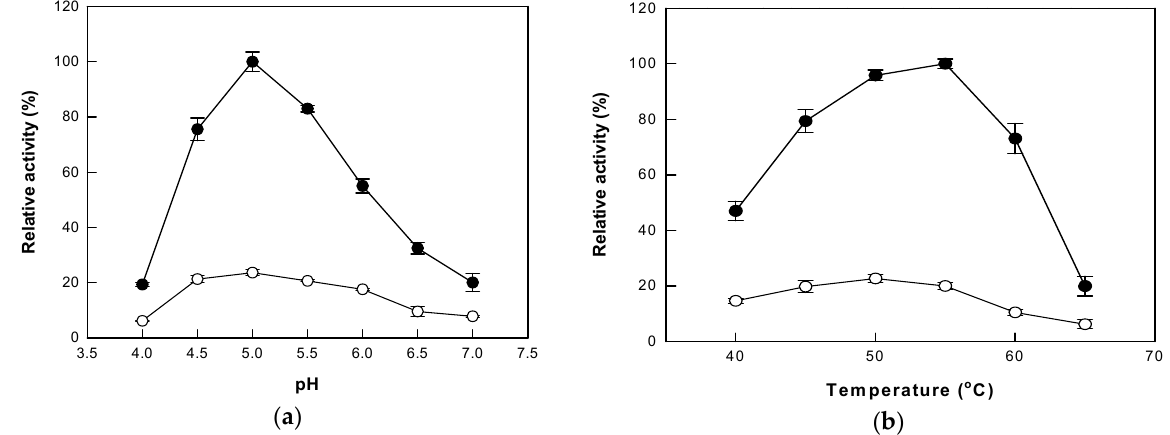
Figure 3. The activity of cytolase PCL5 with changes in ( a ) pH and ( b ) temperature under atmospheric pressure (open circle) and high hydrostatic pressure (closed circle). Data represent the means of three experiments ± standard deviation.